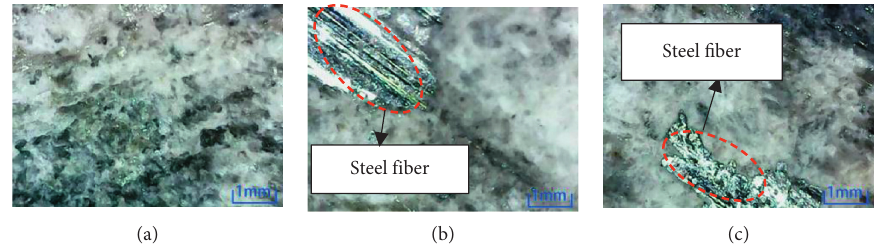
Figure 27: Microscopic observation of specimen soaked in Na